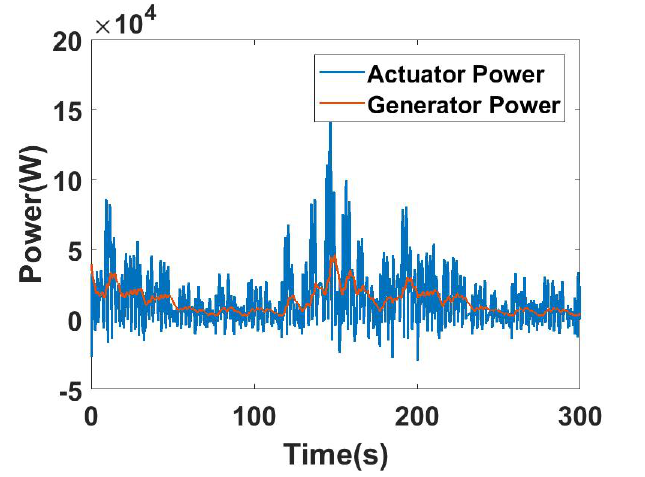
Figure 13. The power extracted by the actuator and the